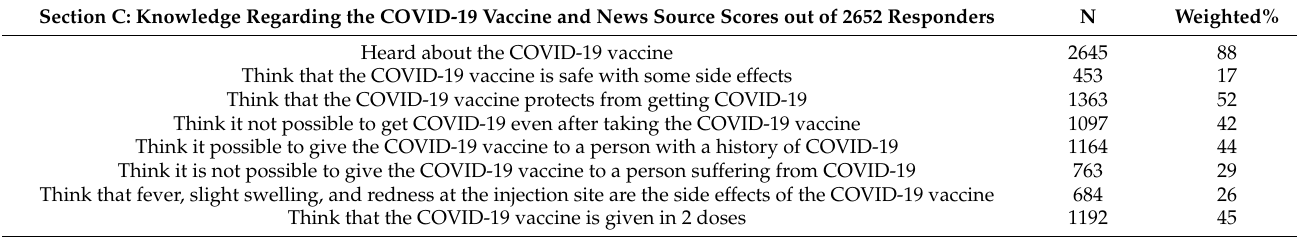
Table 3. Knowledge levels of the respondents regarding the COVID-19 vaccine and the sources of information (N = 3000). Section C: Knowledge Regarding the COVID-19 Vaccine and News Source Scores out of 2652